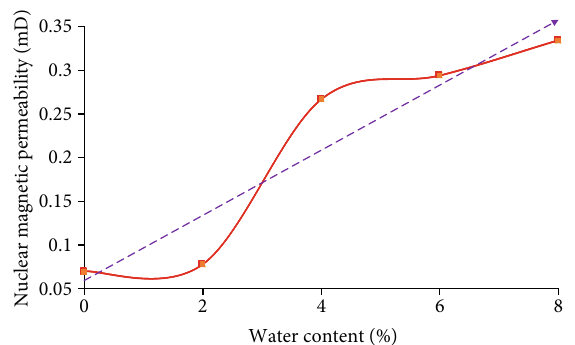
Figure 3: Variation in nuclear magnetic permeability of coal rock samples with water